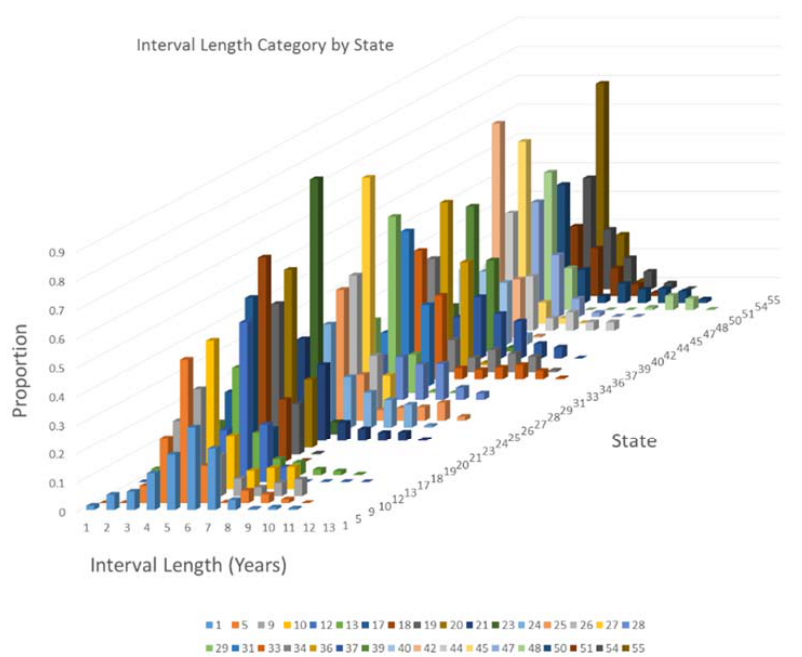
Figure 3. The interval length one ‐ year categorical distributions in FIADB for 34 States in the United States, listed by the two digit State Codes given in Table 1, for MidYears ranging from 1996 to 2014.